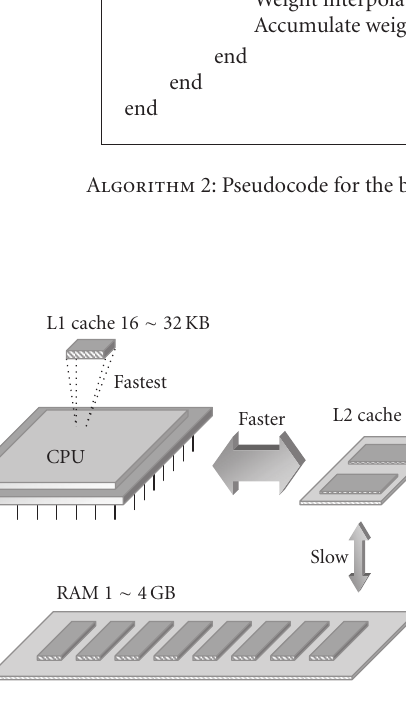
Figure 7: Mechanism for CPU to access data via multilevel